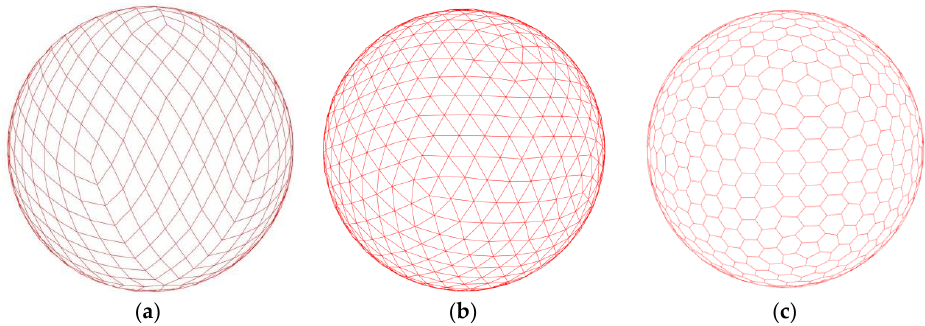
Figure 3. Different spherical grids. ( a ) diamond grid; ( b ) triangular grid; and ( c ) hexagonal grid.